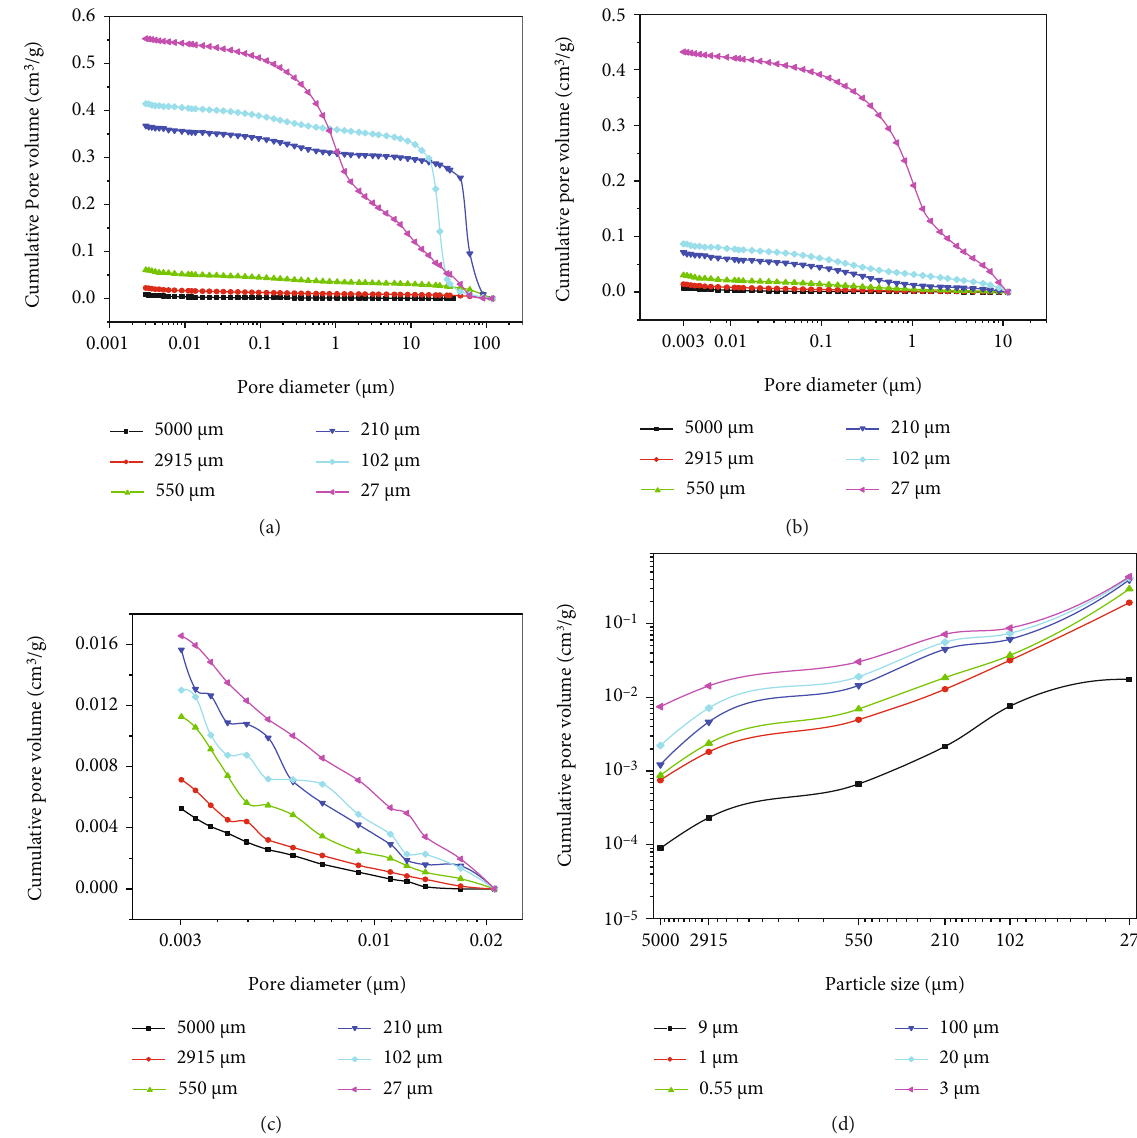
Figure 1: Cumulative mercury intrusion volume of shale samples with di ff erent particle sizes: (a) complete mercury intrusion curves; (b) removal of mercury intrusion volume in pores larger than 10 μ m; (c) removal of mercury intrusion volume in pores larger than 20nm; (d) cumulative mercury intrusion volume of shale with di ff erent particle sizes for di ff erent pore